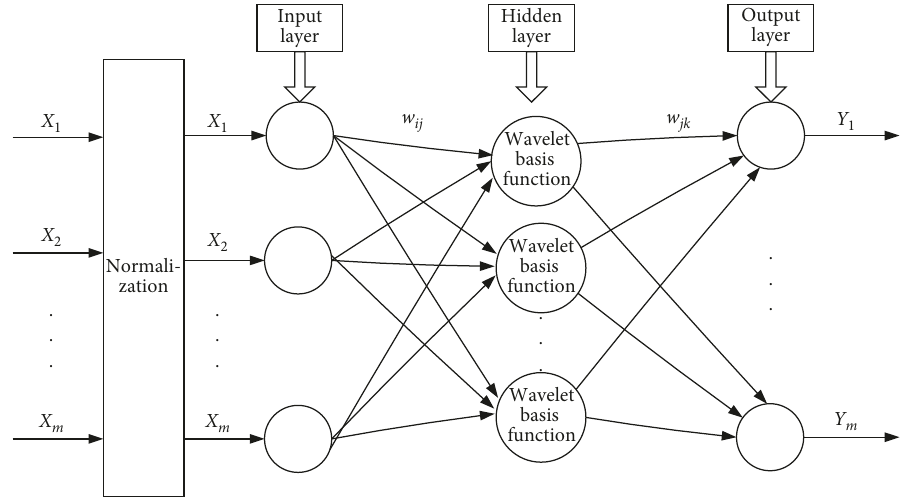
Figure 3: Topology of the wavelet neural